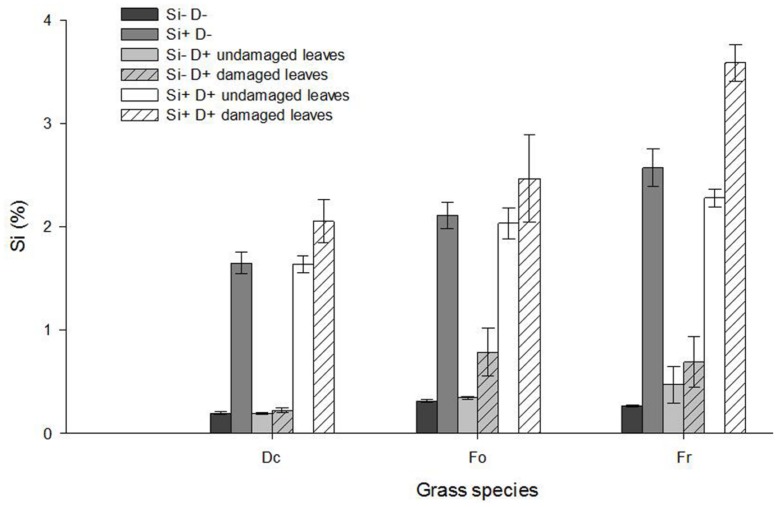
Leaf Si concentration (%) of D. cespitosa (Dc), F. ovina (Fo) and F. rubra (Fr) plants treated with no Si addition and no damage (Si- D-), Si addition only (Si+ D-), damage only (Si- D+), and both Si addition and damage (Si+ D+). Values represent mean ± SE bars of seven replicates.